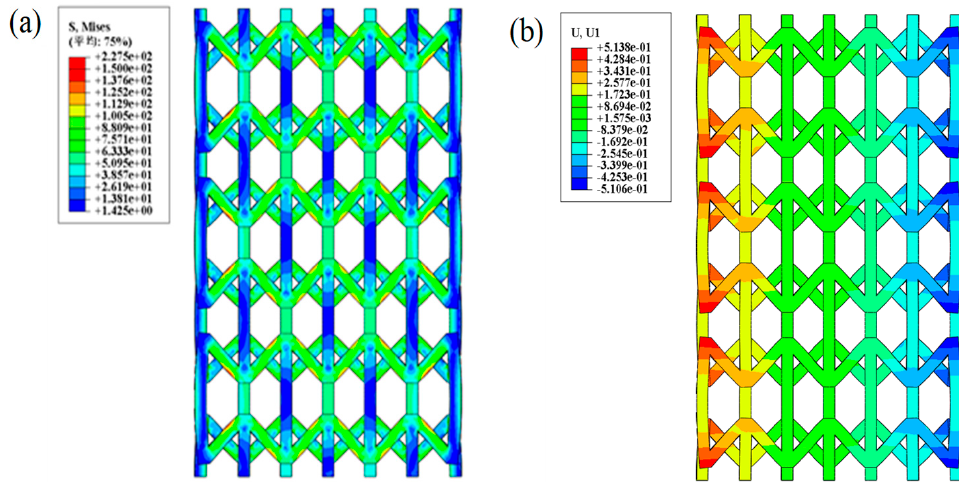
Figure 4. FE simulation of compression test of the 3D auxetic structure: ( a ) Stress distribution ( b ) Stroke